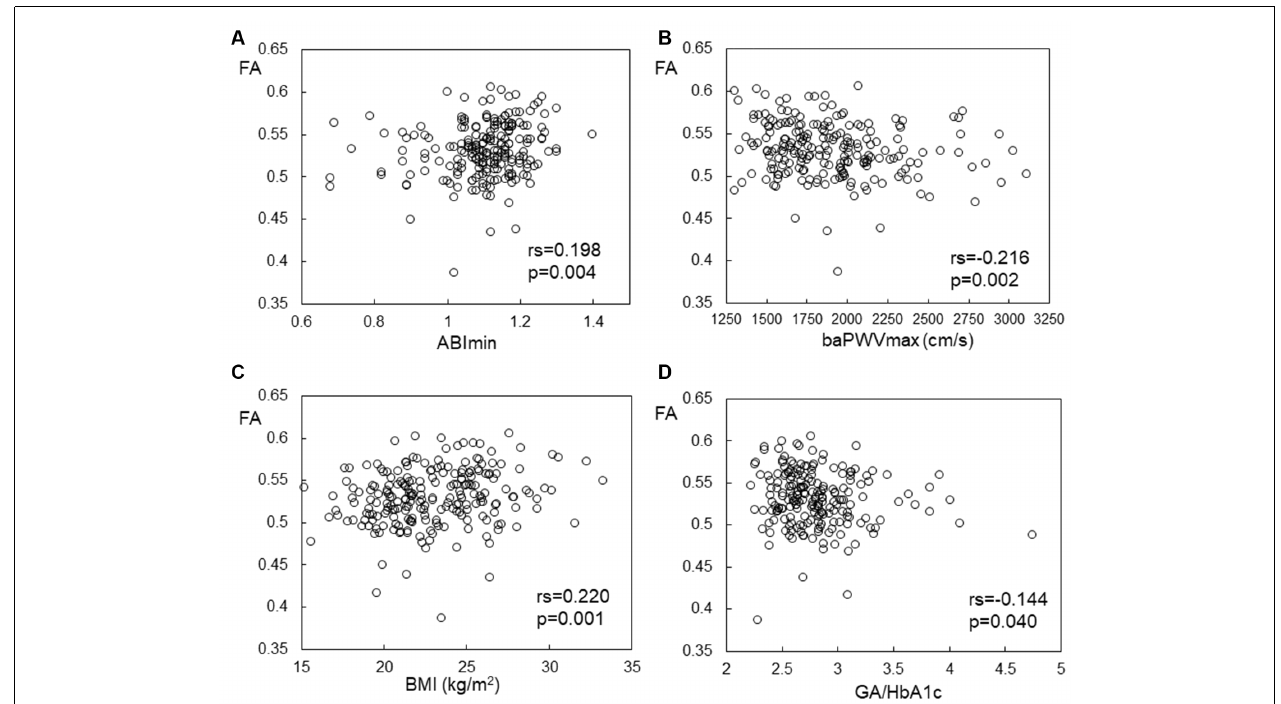
FIGURE 1 | Correlation between FA in the left ATR and (A) ABImin, (B) baPWVmax, (C) BMI, and (D) GA/HbA1c. FA, fractional anisotropy; ATR, anterior thalamic radiation; ABI, ankle brachia index; baPWV, brachial-ankle pulse wave velocity; BMI, body mass index; GA/HbA1c, glycoalbumin/glycohemoglobin